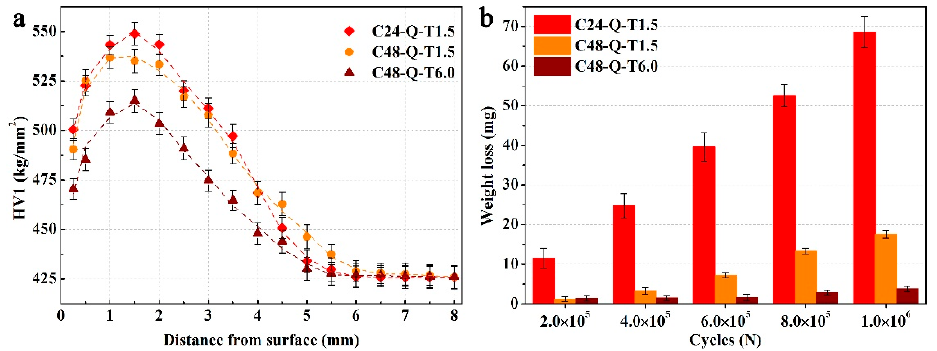
Figure 6. Hardness distribution from surface to core of the worn layer ( a ) and weight loss ( b ) of the specimens processed with different carburizing/tempering durations after friction-wear test.